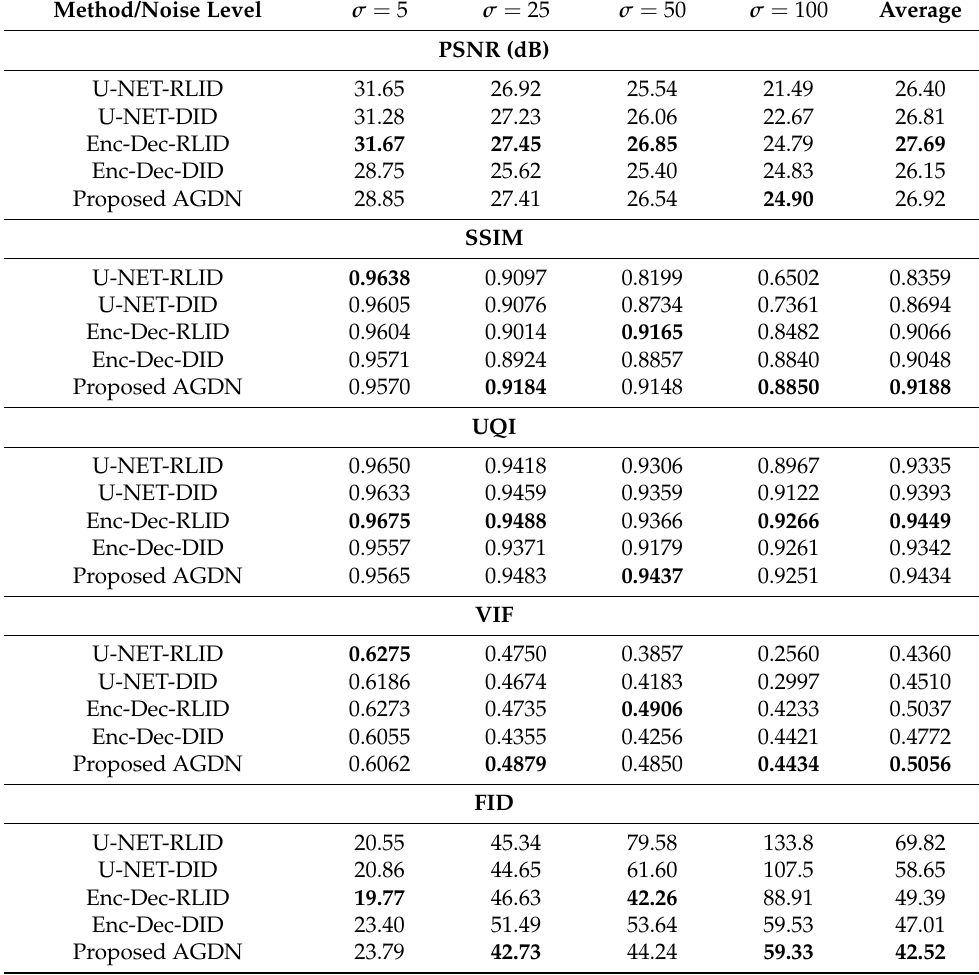
Figure 5. The different network structures for the image generation network. The left one is the encoder-decoder structure, where first the image is encoded to some latent space, and then decoded for target image reconstruction. The right one is the U-NET structure, where the encoder and decoder are connected with skip-connections. Table 8. Quantitative results of different methods with primary two configurations of generating the model on several noise levels. Bold results show good